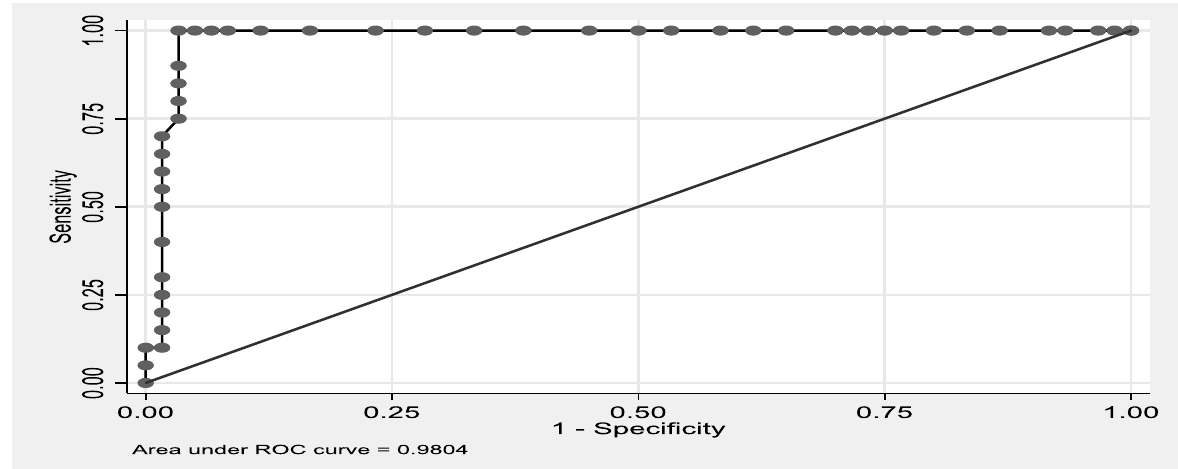
Fig. 4 Receiver operating characteristics curve (ROC curve) for the discriminatory power of FABP in the differentiation between microalbuminuria vs normal control